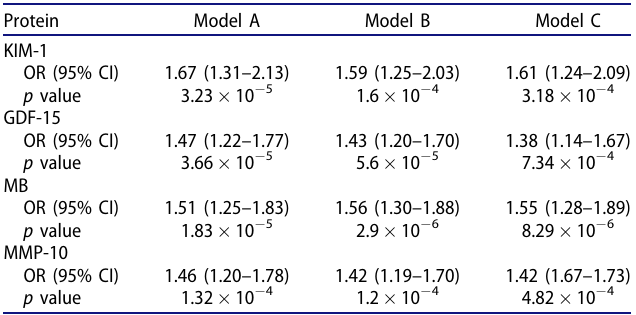
Figure 1. Discovery and replication of the association between 80 circulating proteins measured by a proximity extension assay, and prevalent diabetic kid- ney disease. Proteins associated at a 5% false discovery rate in the discovery sample were tested in the replication sample, and considered successfully repli- cated at the nominal significance level of 0.05. Two-thirds of the subjects ( n ¼ 542) were analyzed in the discovery sample, and one-third of the subjects ( n ¼ 271) were analyzed in the replication sample. Table 2. Multivariable logistic regression models for the association between discovered and replicated proteins and diabetic kidney disease in the whole sample.